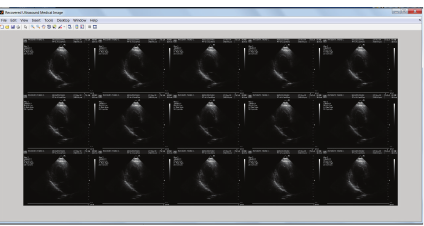
Figure 14: Recovered ultrasound medical images after watermark- ing authentication process.